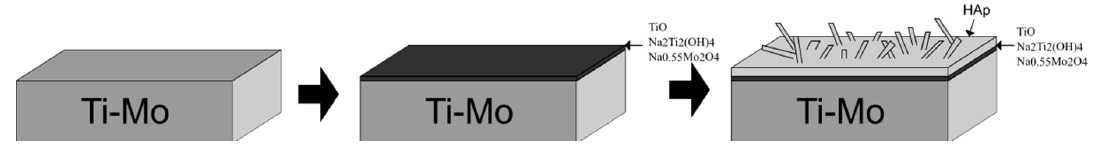
Figure 16. The schematic presentation of HAp formation on TixMo specimens.